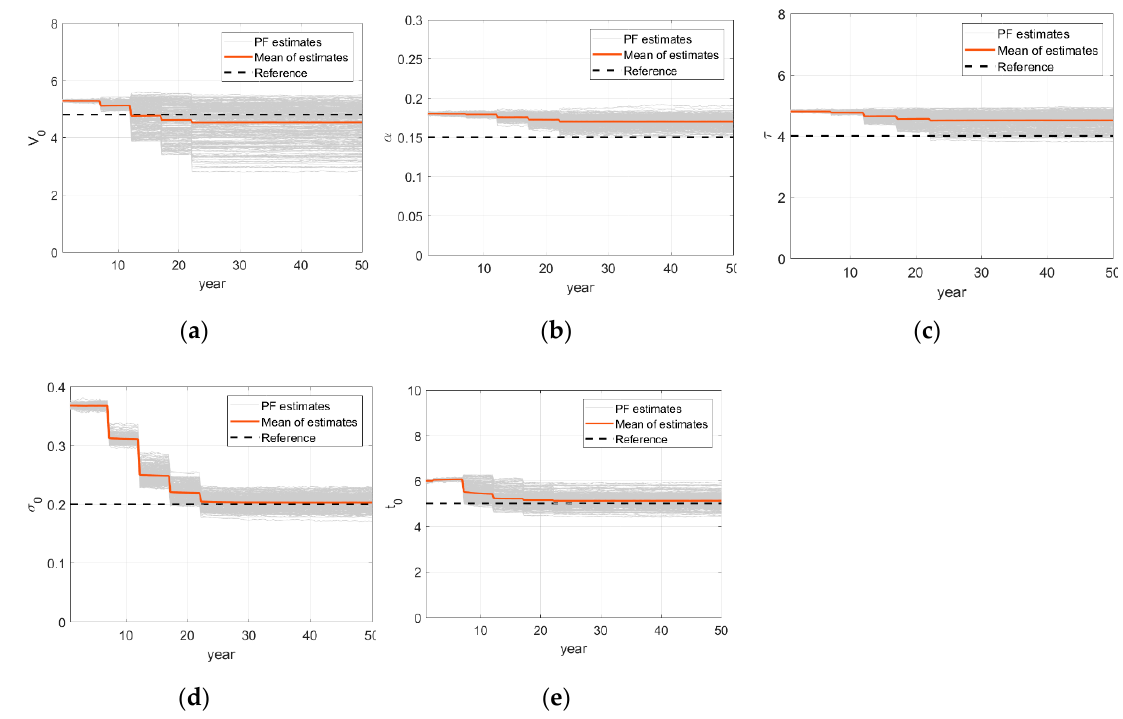
Figure 11. Updating time histories of corrosion model parameters: ( a ) Parameter V o ; ( b ) Parameter α ; ( c ) Parameter τ ; ( d ) Parameter σ o ; ( e ) Parameter t o